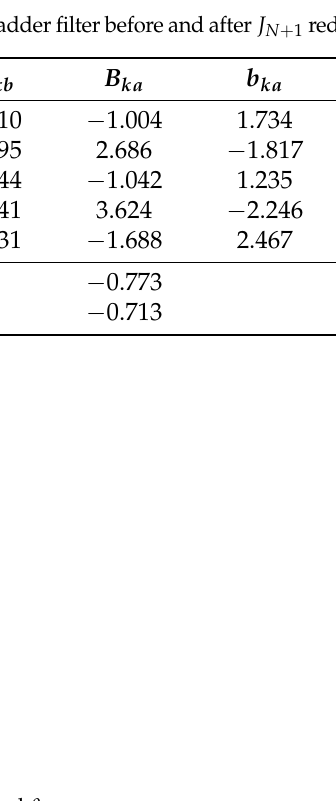
Figure 13. Input and output reflection coefficient θ 11 and θ 22 .